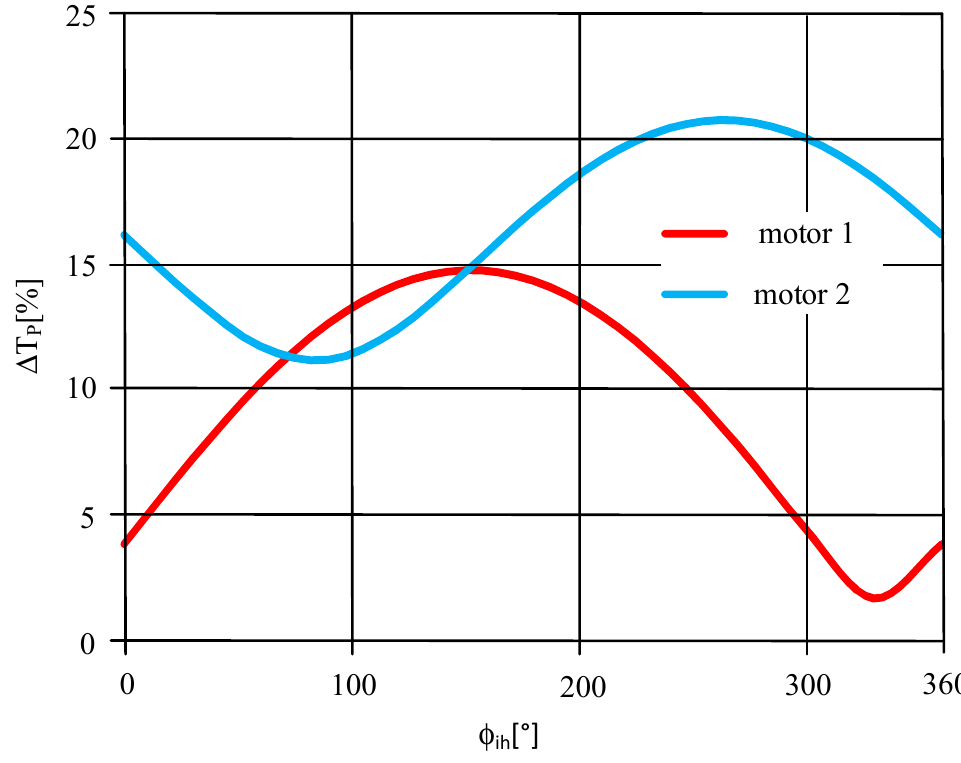
Figure 16. Pulsating torque component Δ T p of the frequency described with (21), (22) versus the angle ϕ ih for ϕ sh = 0°, the work with a constant rotational speed, voltage fluctuation of the frequency equal to f m = 7 Hz and f m = 30 Hz for motor1, motor2, respectively.